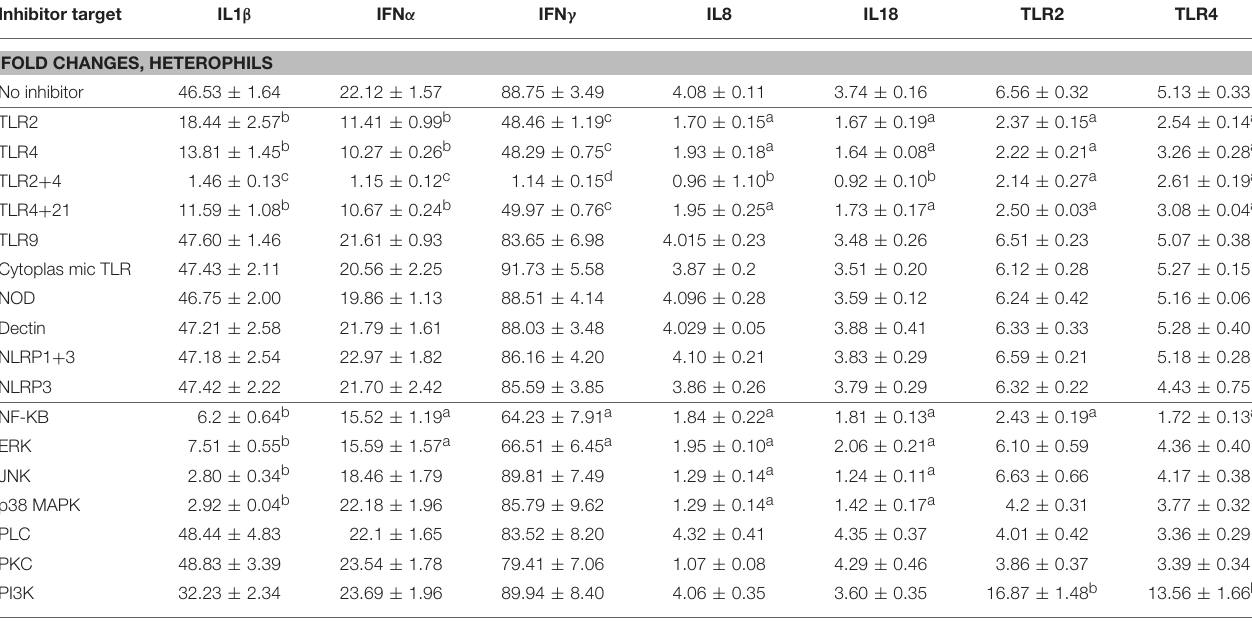
TABLE 4 | Transcription in heterophils is TLR2 and TLR4 dependent and involves intracellular mediators. Inhibitor target IL1 β IFN α IFN γ IL8 FOLD CHANGES,